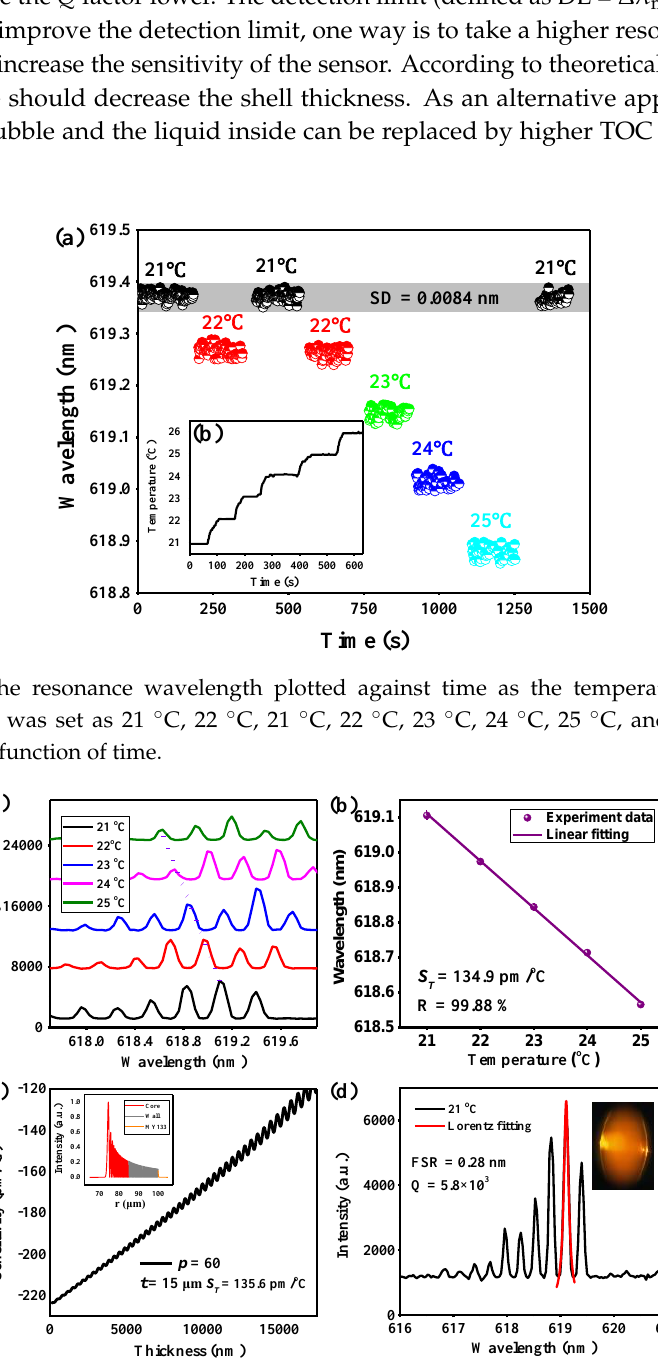
Figure 8. ( a ) The laser spectra of the WGM resonance at a temperature from 21 to 25 °C, with 1 °C increments. ( b ) The lasing resonance wavelength shifts as a linear function of the temperature. ( c ) The radial mode number was calculated to be 60. Inset, the electromagnetic field distribution of p = 60 in t = 15 μm. ( d ) The laser spectra of the WGM resonance at 21 °C. Inset, the CCD image of excited BMR.